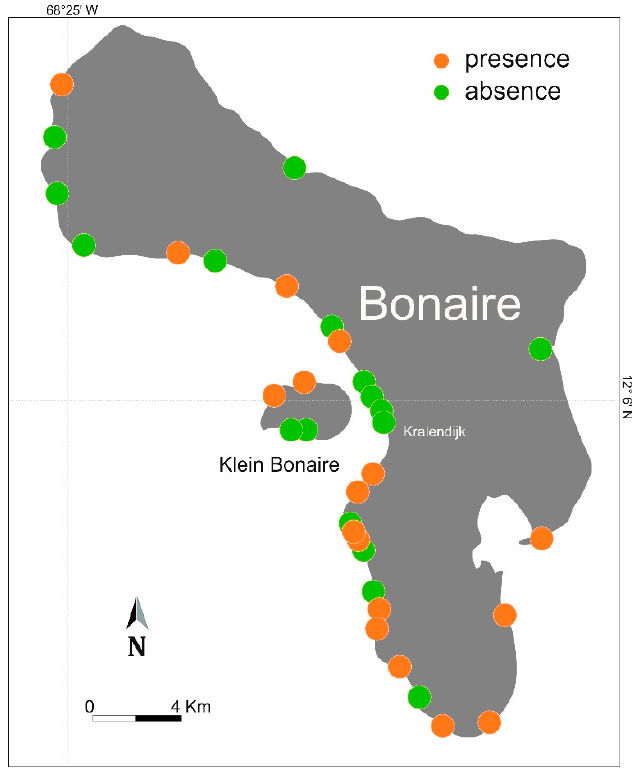
Figure 1. Map of Bonaire island showing locations where the Stylaster - Millepora association was found among all sites surveyed.